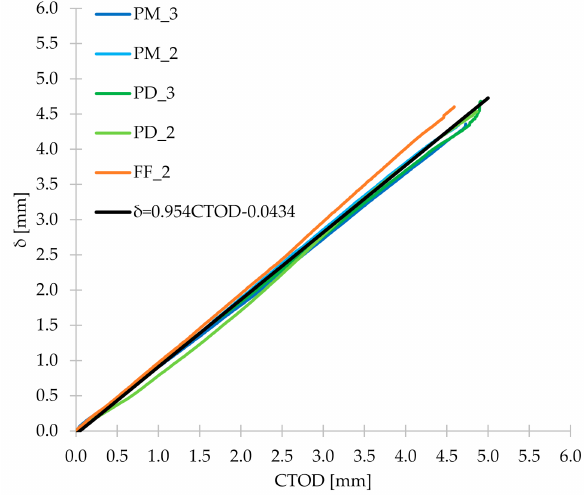
Figure 22. CTOD- δ diagram for the tested concrete mixes together with Equation (15) proposed by the